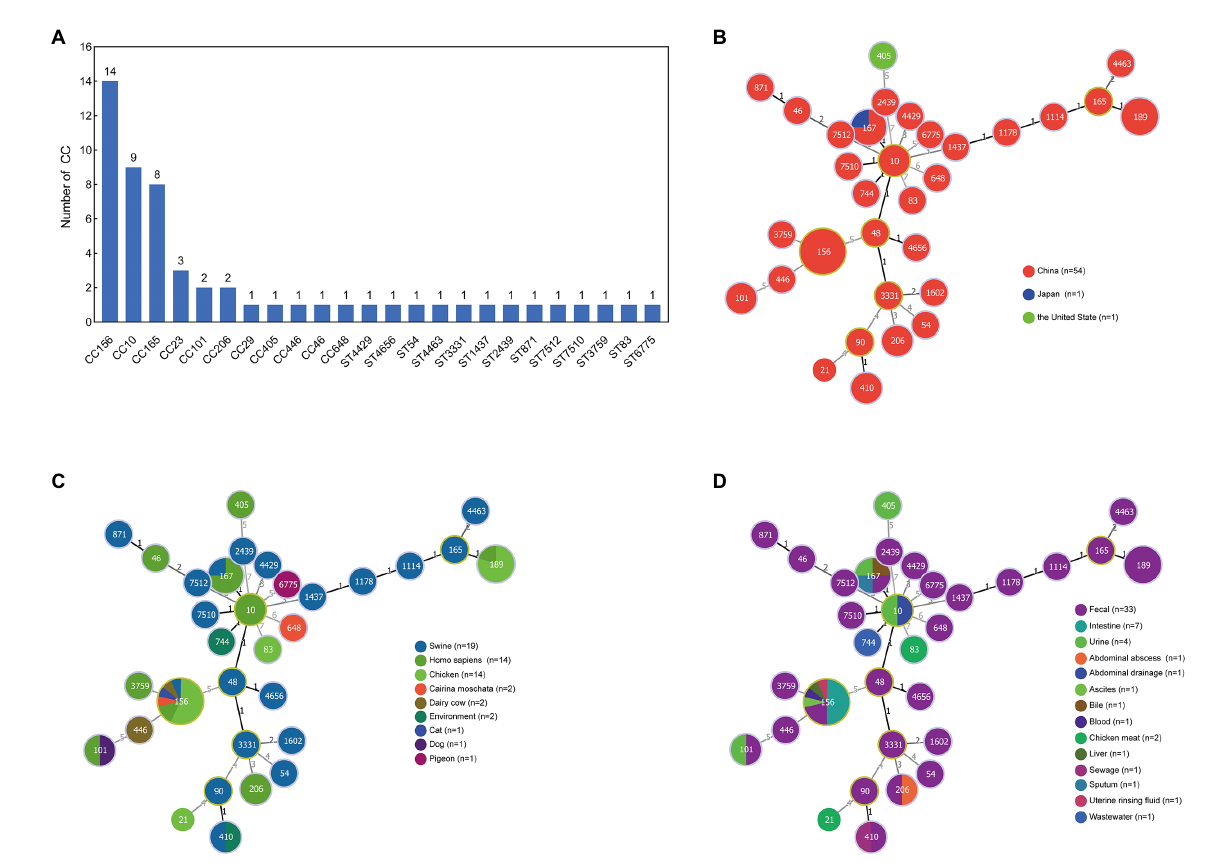
FIGURE 1 Analysis of sequence type (ST), country, host and source of 56 MNPECs. (A) Distribution of sequence type. Each node represents a distinct country (B) , host (C) and source (D) . The size of the circle represents the number of isolates with the same ST profile. The number on the line represents the count of the locus variants for ST.